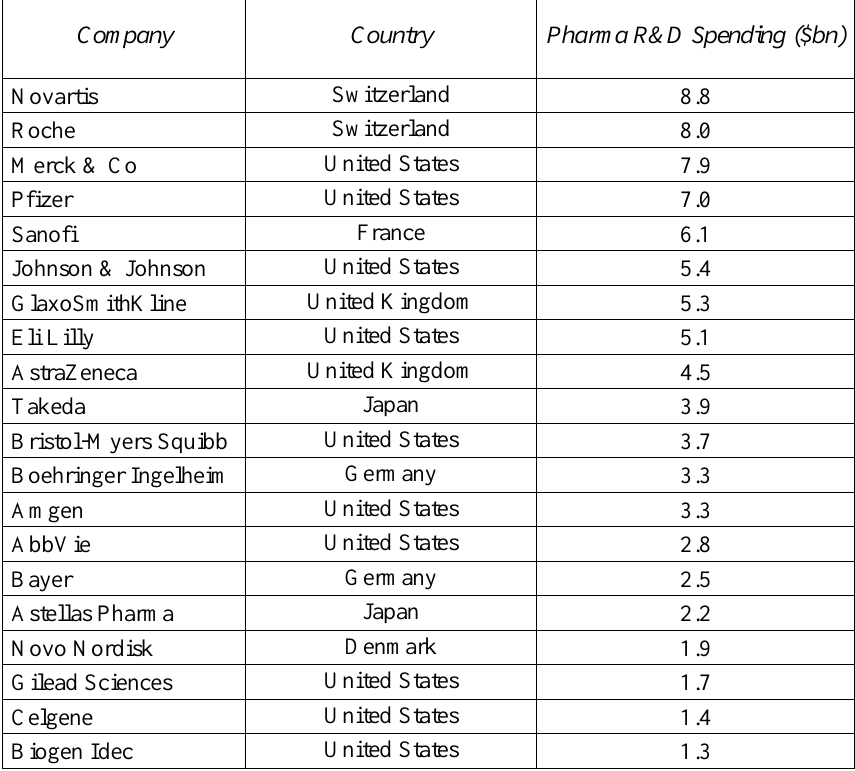
Table 3: Pharmaceutical R&D Expenditure. Year 2012. Top 20